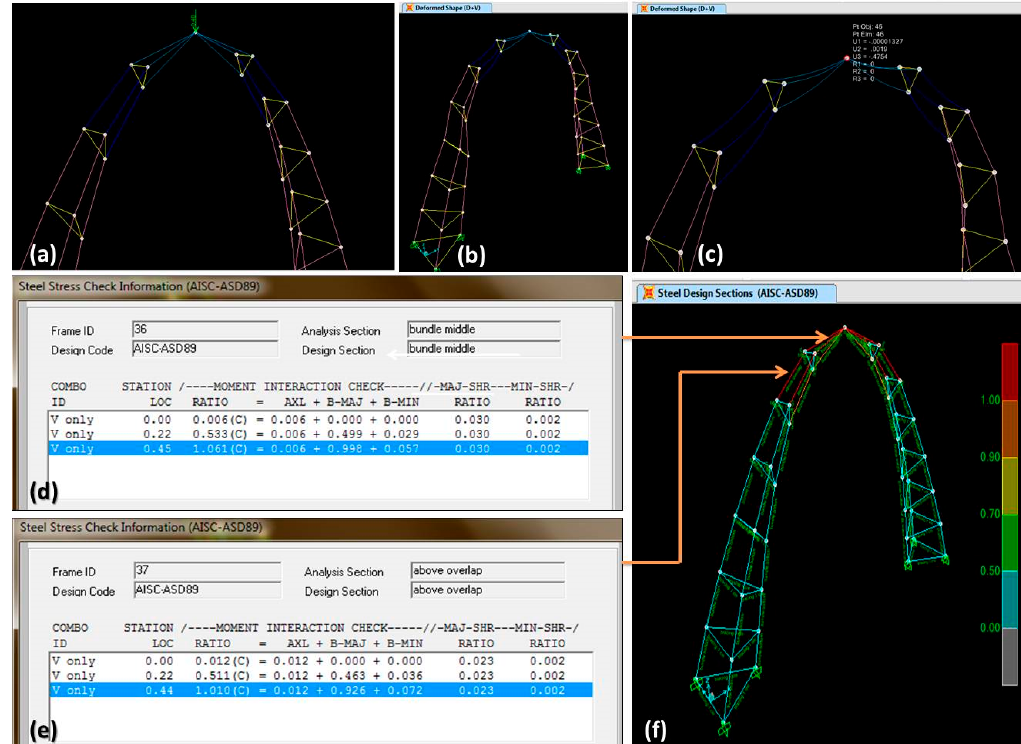
Figure 29. Digital analysis of the system under own weight and vertical load of 4 kN. ( a ) Initial shape ( b ) Deformed shape. ( c ) Vertical displacement (475 mm). ( d ) Stress check information of the top middle bundles (ratio = 1.061) ( e ) Stress check information of the portion above overlap in the middle bundles (ratio = 1.010). ( f ) Failure is concentrated in the top middle bundles and the portion above the overlap in the middle bundles.